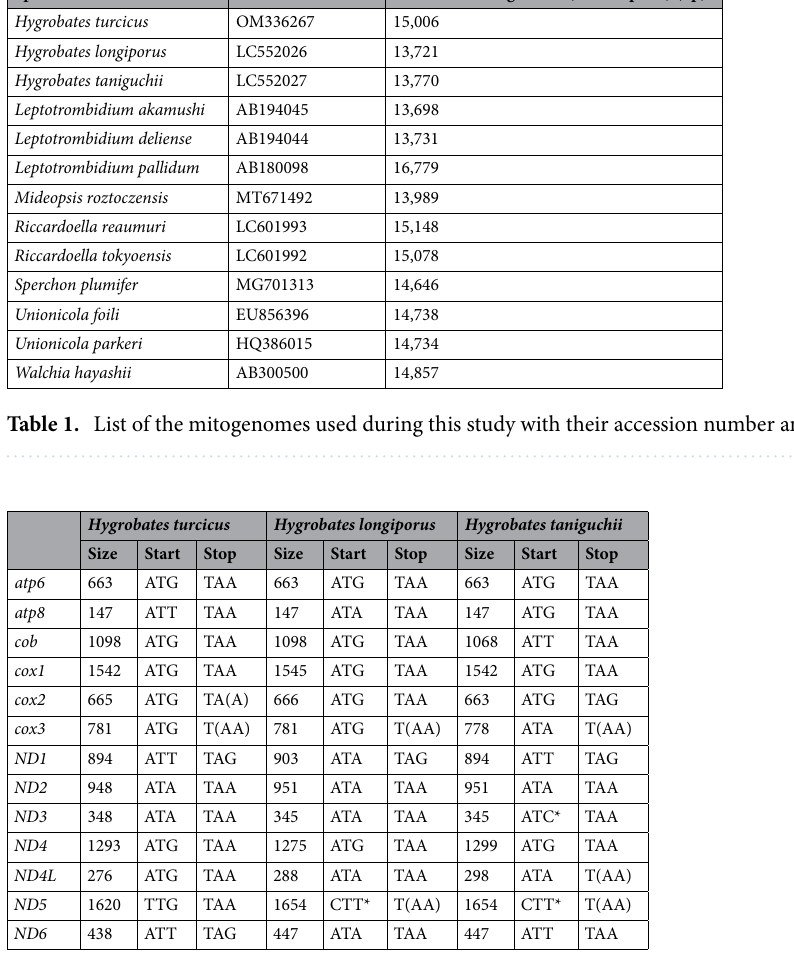
Table 2. Comparison of the mitochondrial protein-coding genes of the three species of Hygrobates . The table indicate the size of the genes (stop codon included) and the type of start and stop codons. The (A) and (AA) indicate an early termination with the stop codon being completed by the addition of 3’ A residues to the mRNA. The * indicates that authors described the start codon as not being found (replaced here by the first codon of the